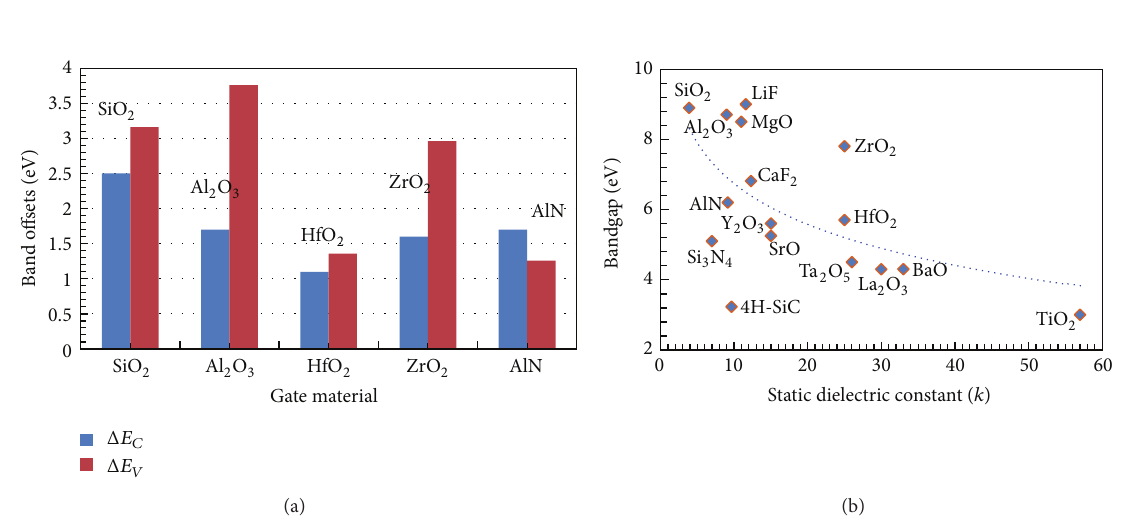
Figure 1: Conduction band (Δ𝐸 𝐶 ) and valence band (Δ𝐸 𝑉 ) offsets of various dielectrics with respect to 4H-SiC material (a) and bandgap energy (𝐸 𝑔 ) as a function of dielectric constant (𝑘) of various materials reported in the literature (b).